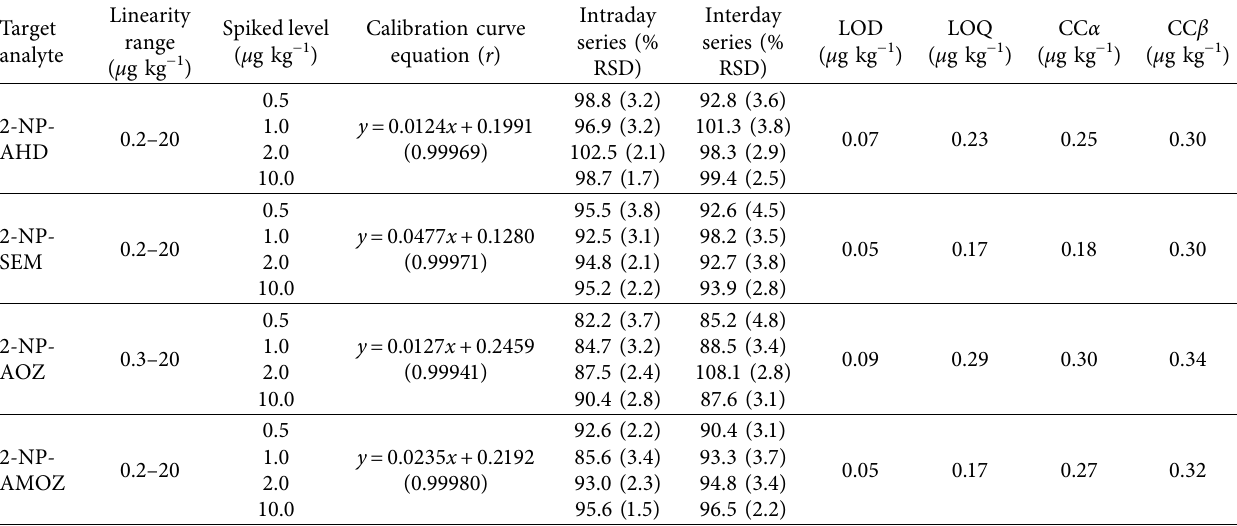
Table 2: Calibration curves, sensitivity, corrected intraday and interday accuracies, and precision for samples spiked with working standard solution ( n �